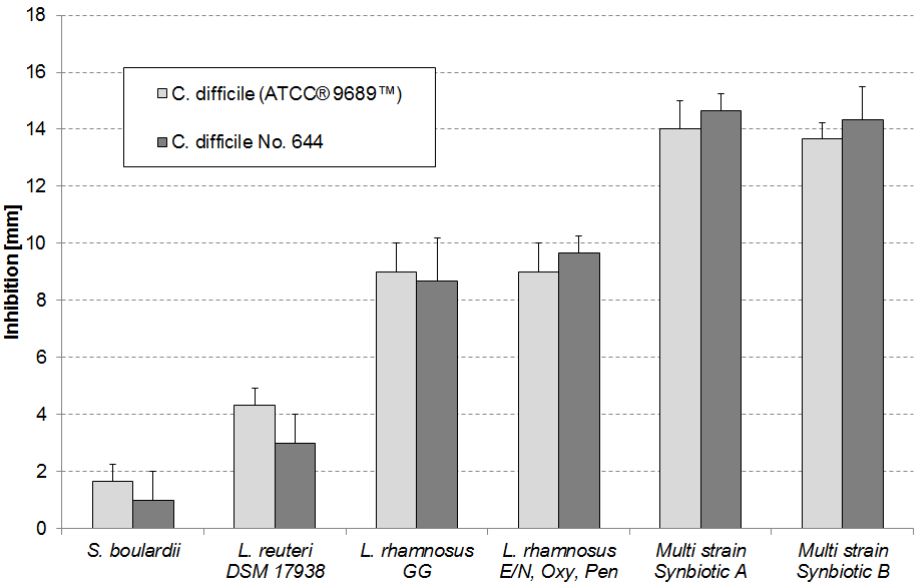
Figure 5. In vitro growth inhibition of C. difficile strains by different probiotics and two multi strain synbiotics. The L. rhamnosus E/N , Oxy , Pen mixture contains the three different probiotics in a CFU ratio of 40%/20%/40%. Detailed information about the composition of the multi strain synbiotics (containing 9 different bacterial probiotic and FOS) are provided under Materials and Methods.